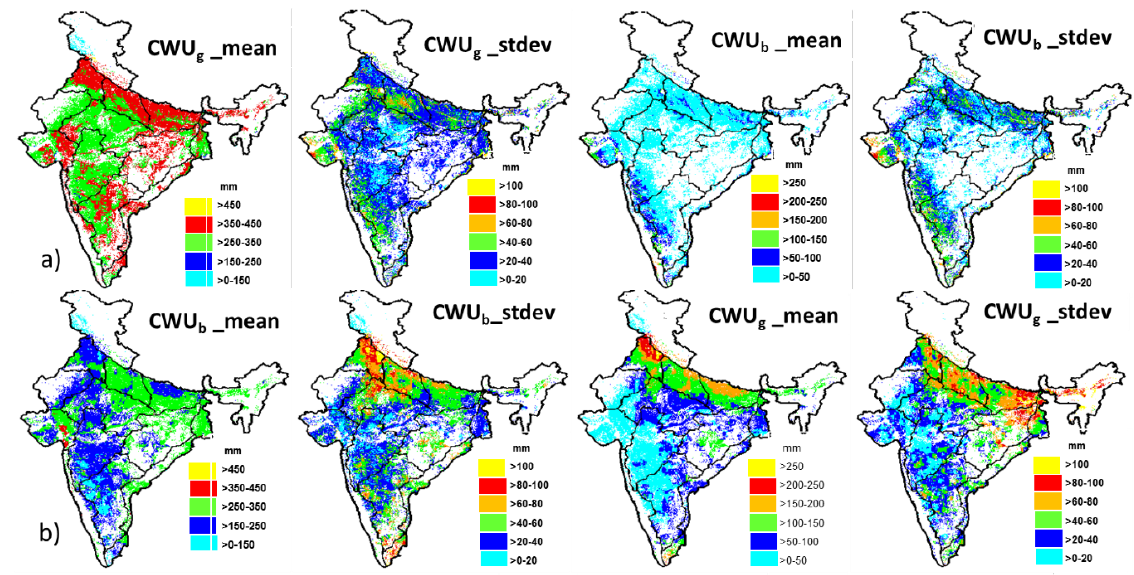
Figure 3: Average pattern and standard deviations of greenand blue water uses over Indian